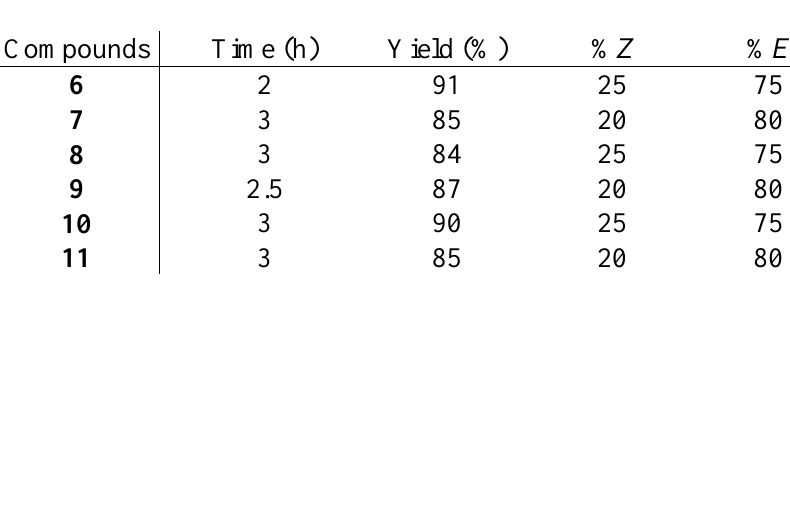
Table 3: Time (h), yield (%) and isomer ratios of compounds